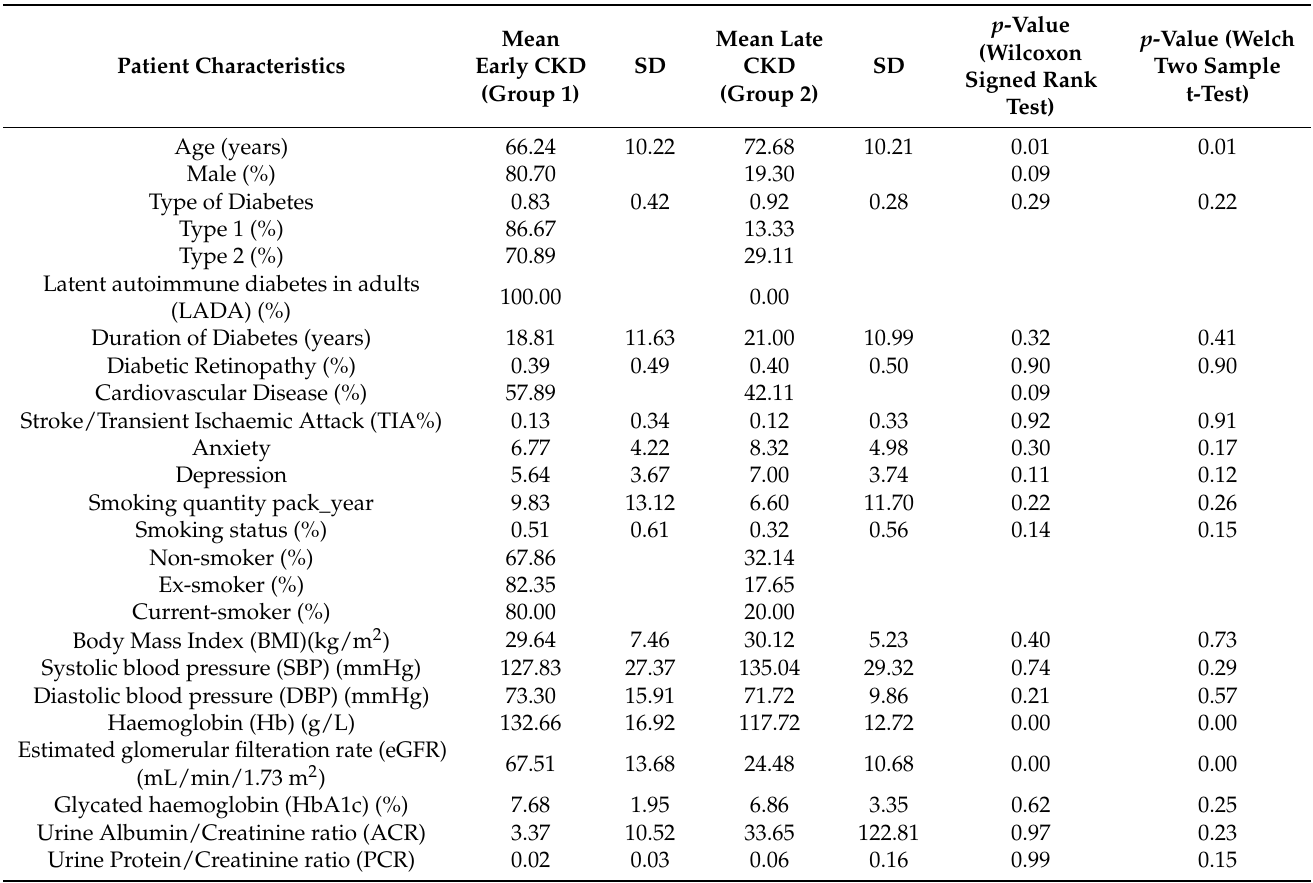
Table 2. Patient Clinical and Biochemical